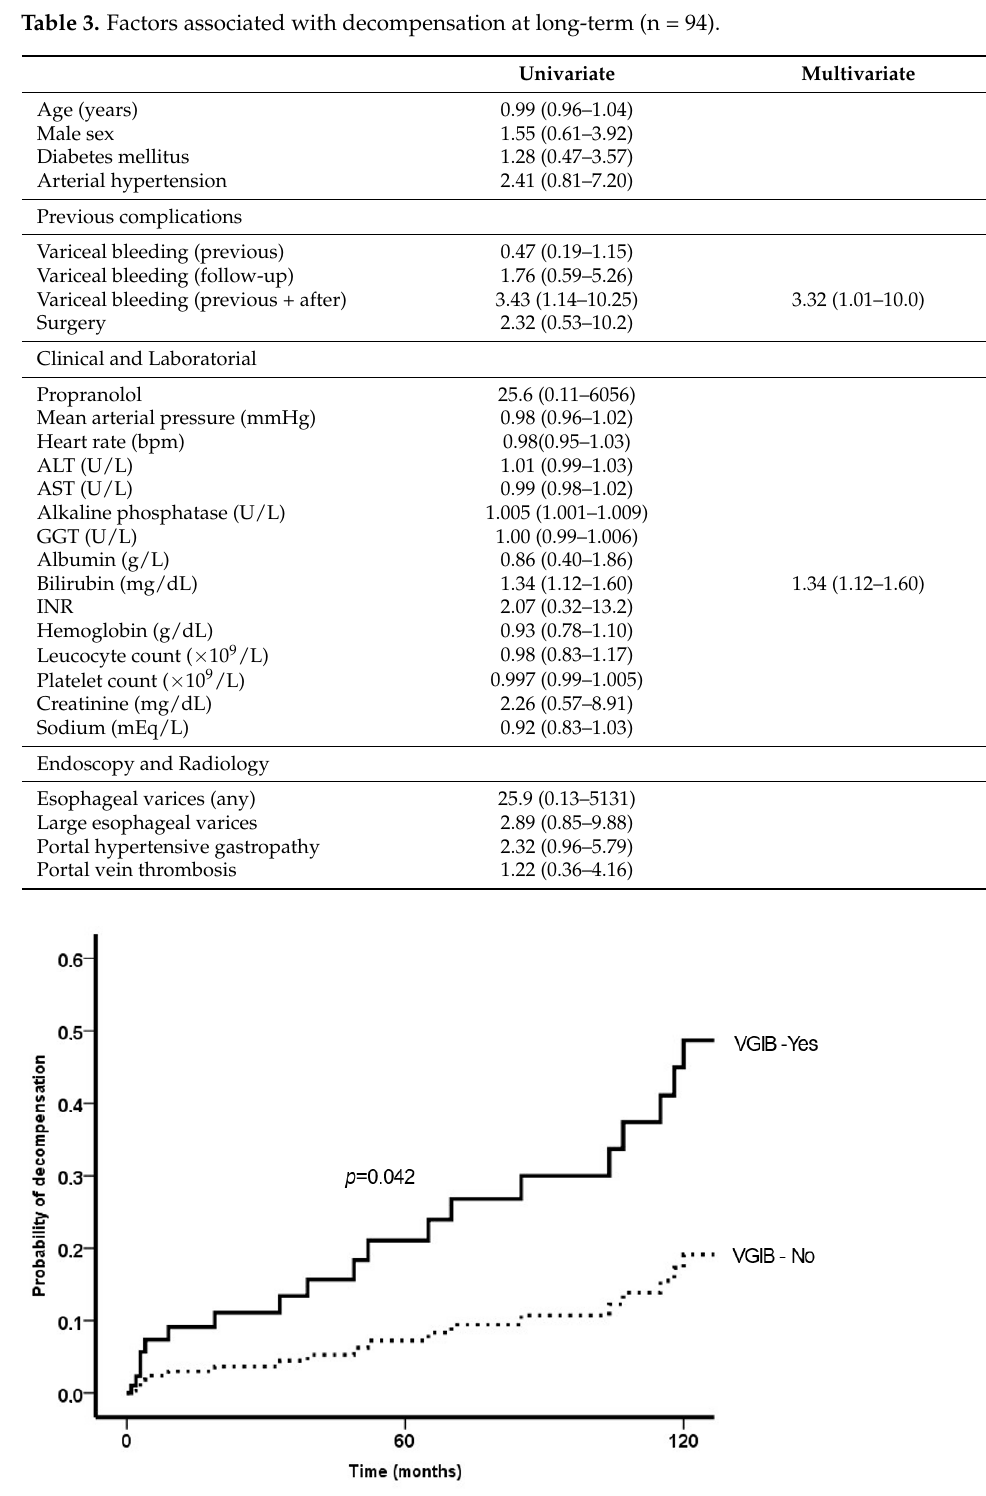
Figure 3. Probability of decompensation according to variceal bleeding (previous to or after follow- up), adjusted by bilirubin.